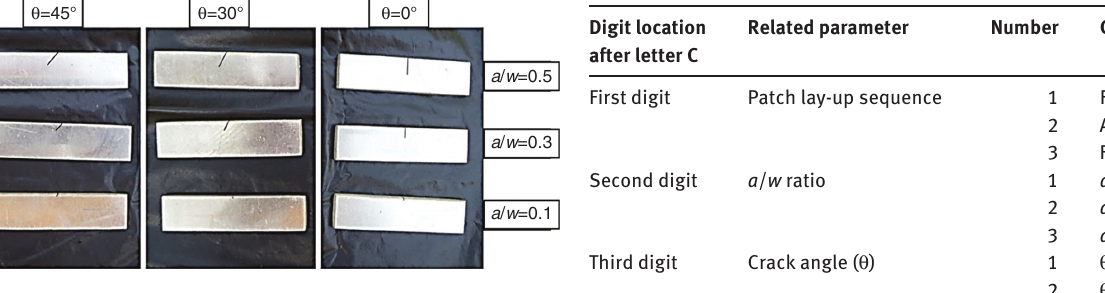
Figure 3 Unrepaired specimens having three different crack length and crack